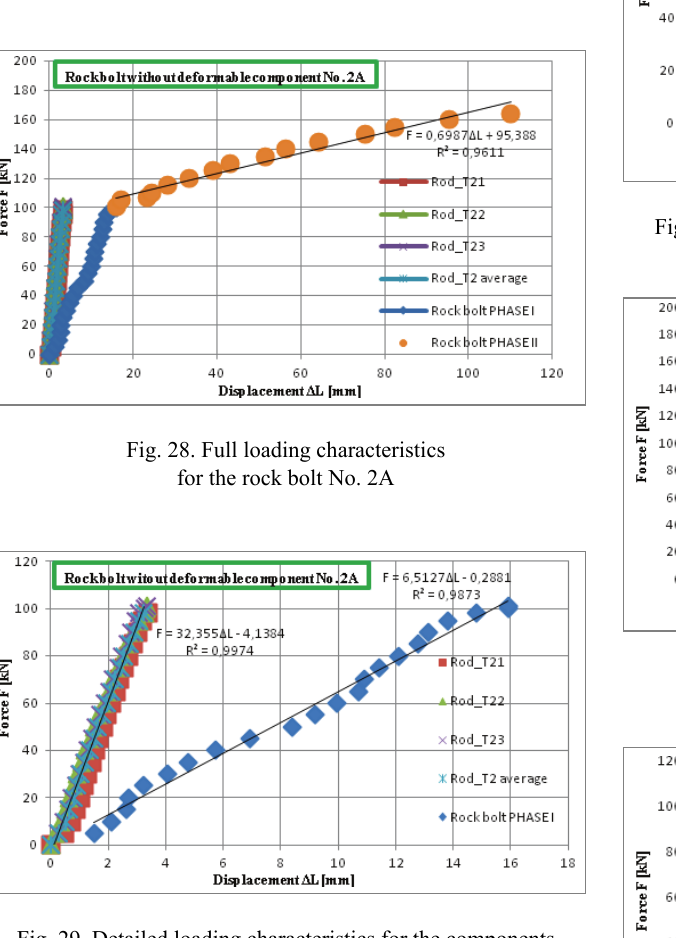
Fig. 29. Detailed loading characteristics for the components of the rock bolt support No. 2A